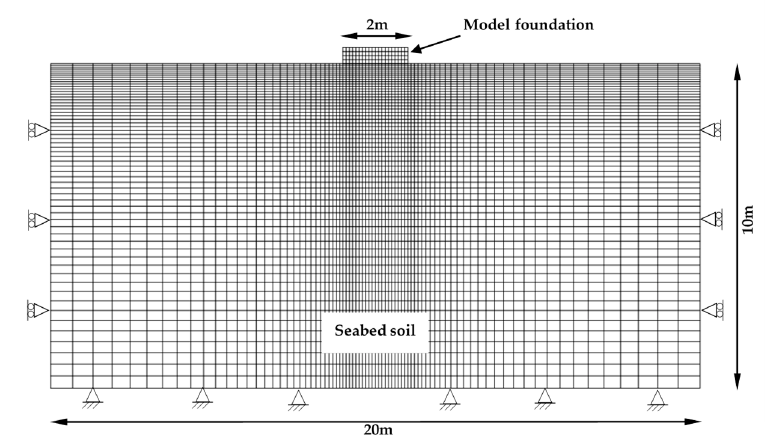
Figure 8. Model and mesh of the numerical analysis.